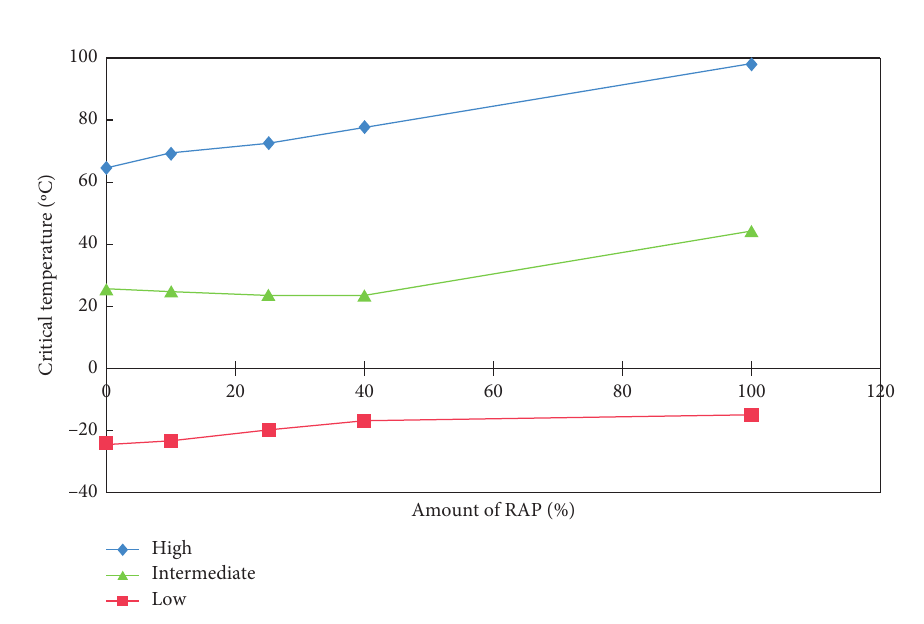
Figure 1: Blending chart for binders with RAP.